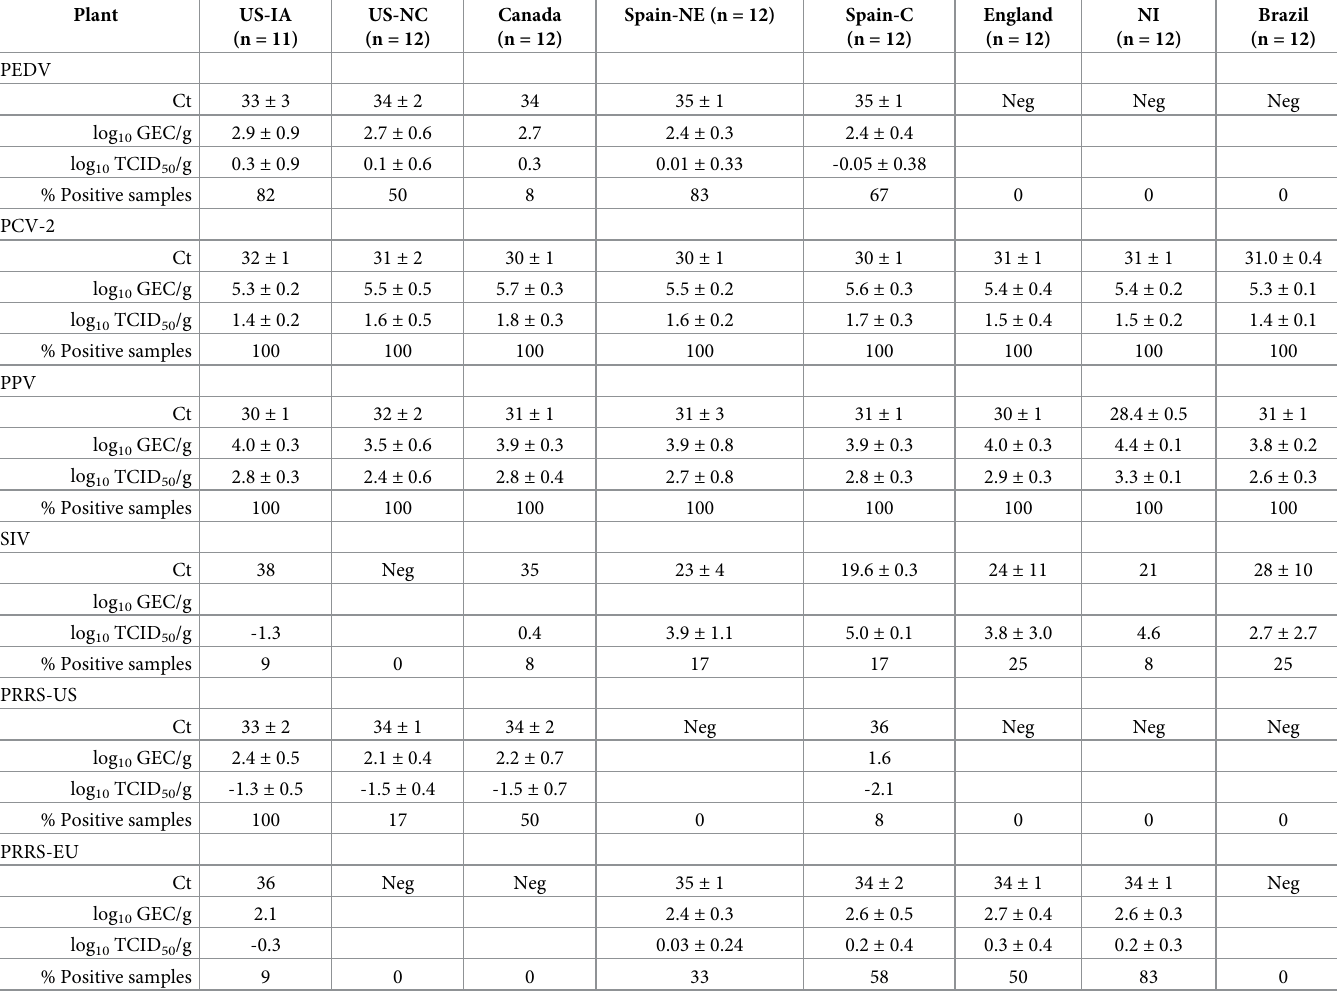
Table 2. Ct values and estimated viral genome presence expressed in log 10 genome equivalent copies (GEC) and log 10 TCID 50 /g spray dried porcine plasma in manufacturing plants located in different swine production areas around the world during the years 2018–2019. Values expressed as Average ± SD for positive samples.